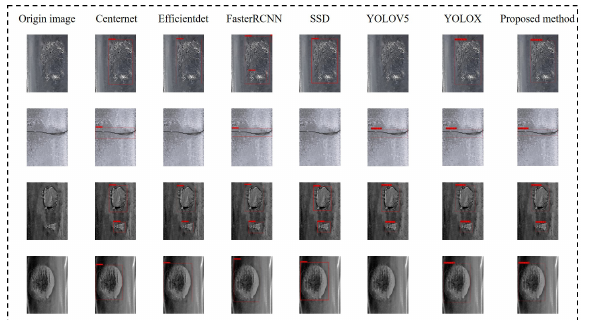
Fig. 11. Result comparison of proposed method and other rail surface defect detection methods.